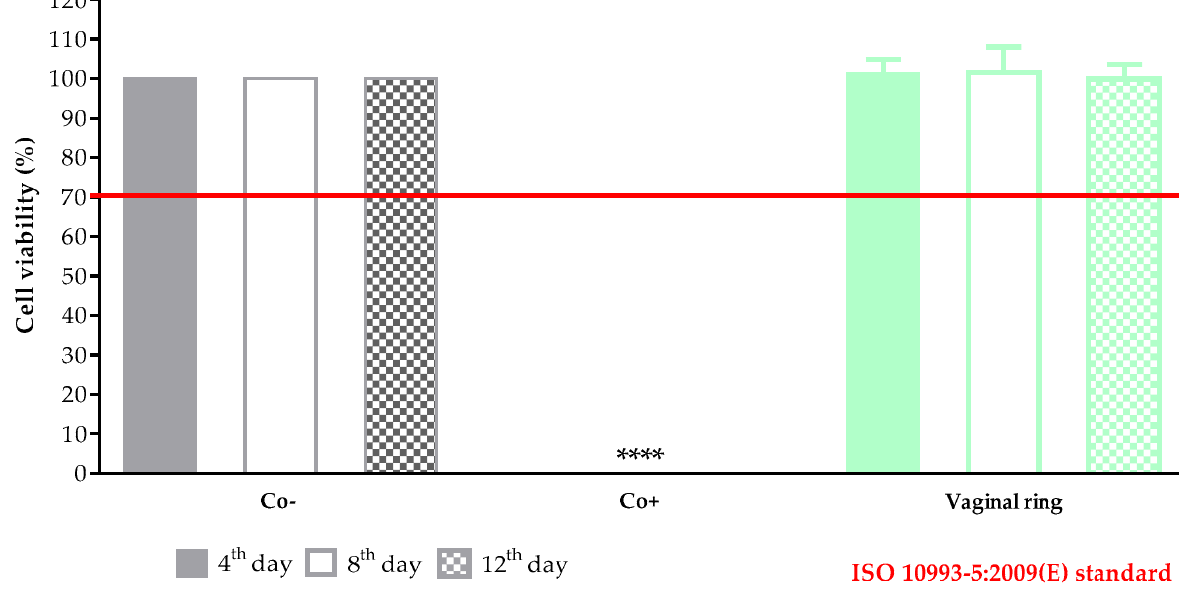
Figure 11. The prolonged cytotoxicity of the 3D printed sample byTPU. MTT cell viability tests were performed on days 4, 8, and 12. Cell viability was expressed as the percentage of untreated control (Co − ). As a positive control (Co+), Triton X 100 (10% w / v ) was used. Data were expressed as means of four independent experiments ± SD.